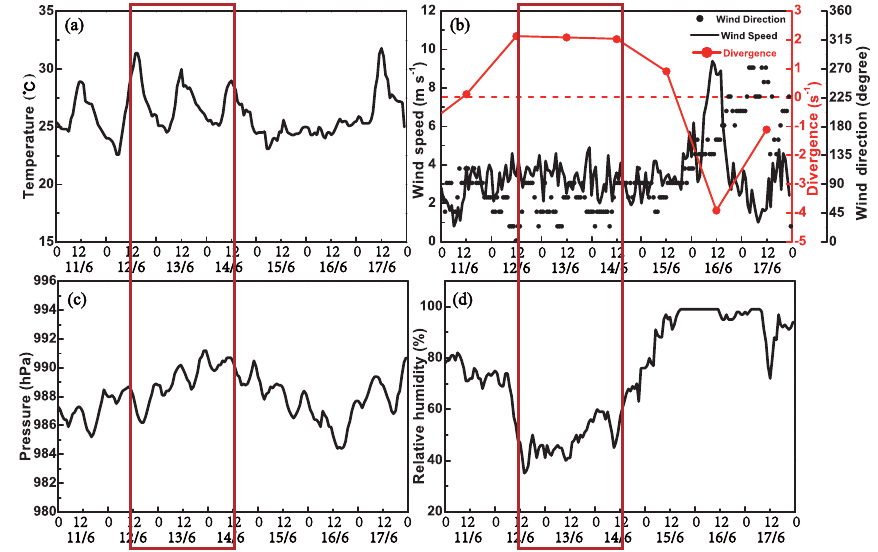
Figure 4. Time series of (a) surface air temperature (b) wind speed, direction and divergence, (c) air pressure and (d) relative humidity observed in the observatory of Xiamen from 11 to 17 June 2014 with the red rectangular columns marking the period of surface O 3 event. The red curve in panel (b) is a daily variation in divergences at 1000hPa over XQR, calculated with NCEP-FNL